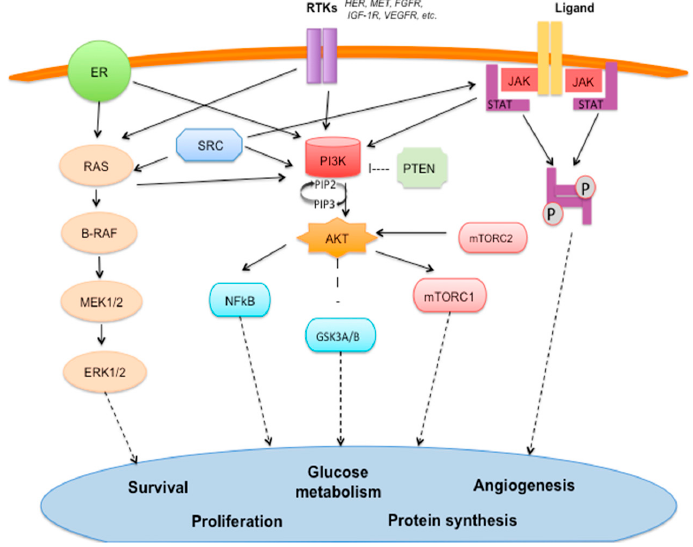
Figure 1. The crosstalking network of signaling pathways involved in breast cancer development and progression: estrogen receptor (ER) signaling pathway, receptor tyrosine kinase (RTK) pathway, PIK3/AKT/mTOR pathway, MAPK signaling pathway, angiogenic pathway, SRC pathway and JAK/STAT pathway. ER: estrogen receptor, RAS: rat sarcoma viral oncogene homolog, B-RAF: murine sarcoma viral oncogene homolog, MEK1/2: MAPK/Erk kinase 1/2, ERK1/2: extracellular-signal-regulated kinase 1/2, SRC: rous sarcoma, RTKs: receptor tyrosine kinases, JAK: Janus kinase, STAT: Signal Transducer and Activator of Transcription, PI3K: Phosphoinositide 3-kinase, PTEN: Phosphatase and tensin homolog, AKT: protein kinase B, NF κ B: nuclear factor κ -light-chain-enhancer of activated B cells, GSK3A/B: Glycogen synthase kinase-3 α / β , mTORC1/2: mammalian target of rapamycin complex 1/2, PIP: phosphatidylinositol phosphate, P: phosphorylated. Solid arrow: activation. Dashed arrow: activation of nuclear transcription factors. T-bar: inhibition.